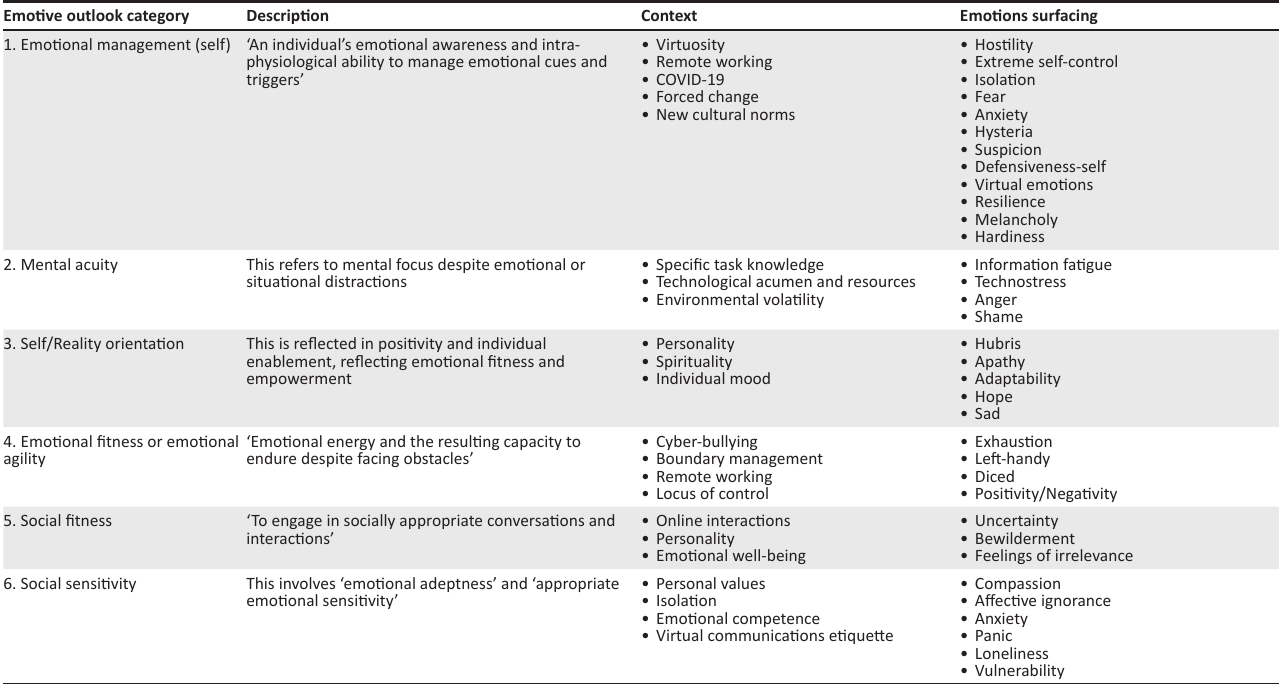
TABLE 1: Emotional constructs context and emotions emerging during